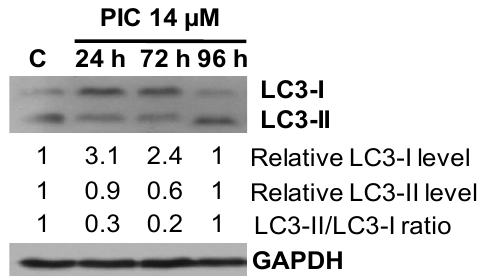
Figure 4. Effect of piceatannol on autophagy pathways in HL-60 cells. Cells were treated with piceatannol (PIC, IC 90 = 14 µM) for 24, 72, and 96 h. The relative levels of LC3-I and LC3-II proteins normalized to loading control GAPDH were quantitated by densitometry. C—control (untreated cells), PIC—piceatannol. Similar results were obtained in three independent experiments.